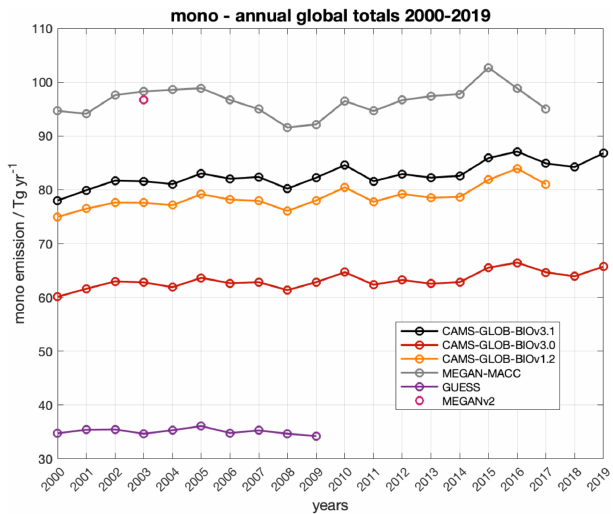
Figure 8. Comparison of monoterpene global annual totals from CAMS-GLOB-BIOv3.1 (black), CAMS-GLOB-BIOv3.0 (red), CAMS-GLOB-BIOv1.2 (orange) and other available inventories within the 2000–2019